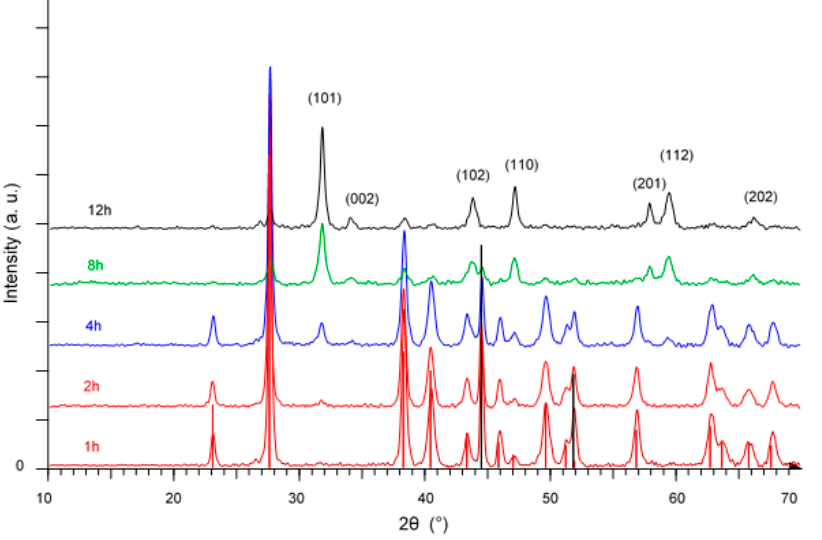
Figure 2. XRD patterns of NiTe 2 prepared mechanochemically after 1 h, 2 h, 4 h, 8 h, and 12 h milling time. Black and red vertical lines represent the precursors Ni and Te, respectively.